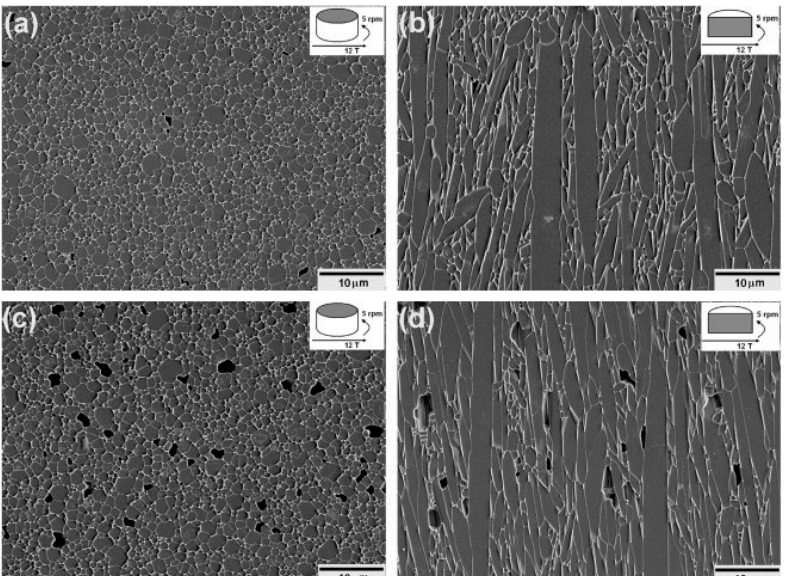
Fig. 28 Polished and plasma-etched surface morphologies of textured Si 3 N 4 specimens: (a, b) surfaces perpendicular and parallel to the c -axis orientation of the specimen prepared using near-equiaxed β-Si 3 N 4 seeds, respectively; (c, d) surfaces perpendicular and parallel to the c -axis orientation of the specimen prepared using rodlike β-Si 3 N 4 seeds, respectively. Reproduced with permission from Ref. [219], © Elsevier Ltd. 2014.